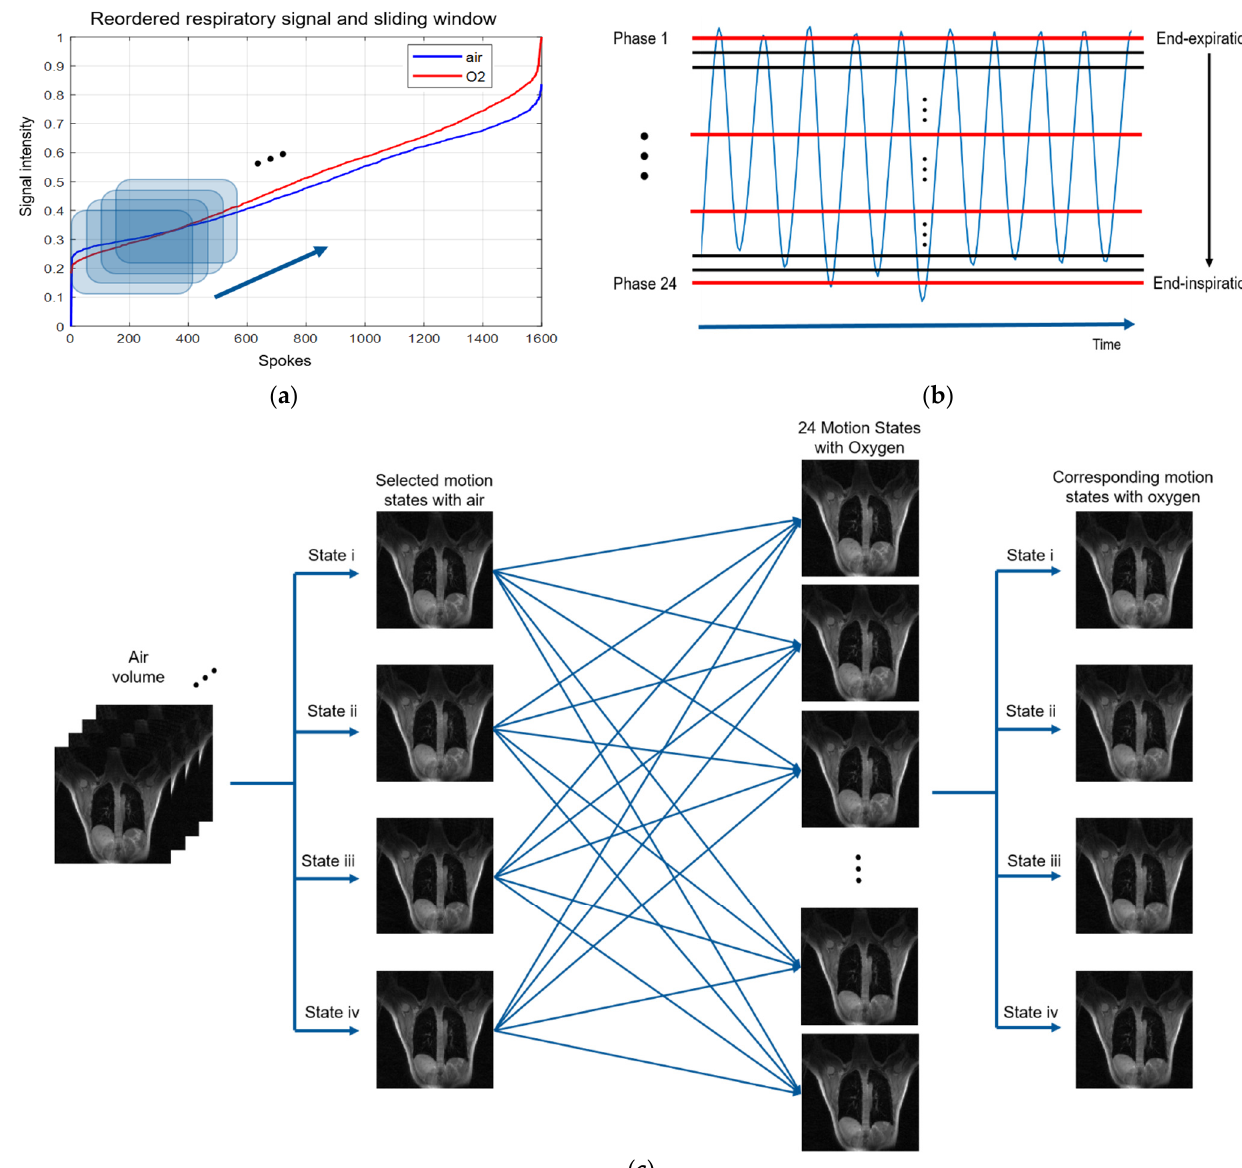
Figure 3. Respiratory phase segmentation. ( a ) Reordered respiratory signals during breathing room air and oxygen. The shadow squares are sliding window containing 450 spokes, reconstructing 24 respiratory states from the end of inspiration to the end of expiration. ( b ) Four representative respiratory states (highlighted in red lines) were selected from these 24 respiratory phases. ( c ) Graphical diagram of air-oxygen respiratory matching states selection. Four respiratory states were selected from air image volume first. The matching respiratory states of oxygen volume were selected manually by comparing with the position of diaphragm. State i~state iv represent the selected respiratory states with air (the second column on the left) and oxygen (the right column).